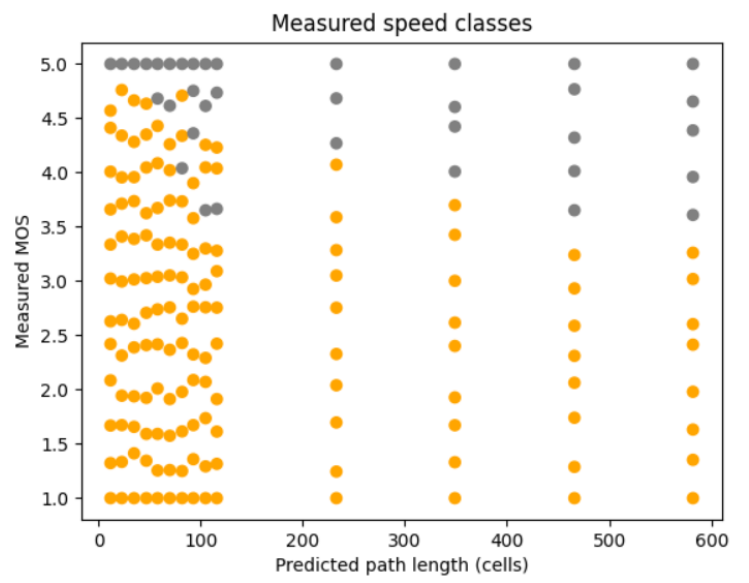
Figure 11. Collected dataset. Orange signifies edge was faster, grey signifies cloud was